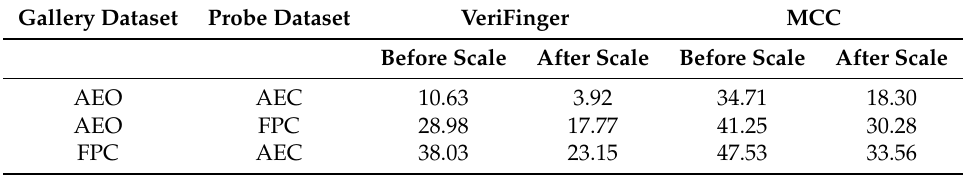
Table 3. EERs of the VeriFinger and MCC algorithms before and after enhancement. Gallery